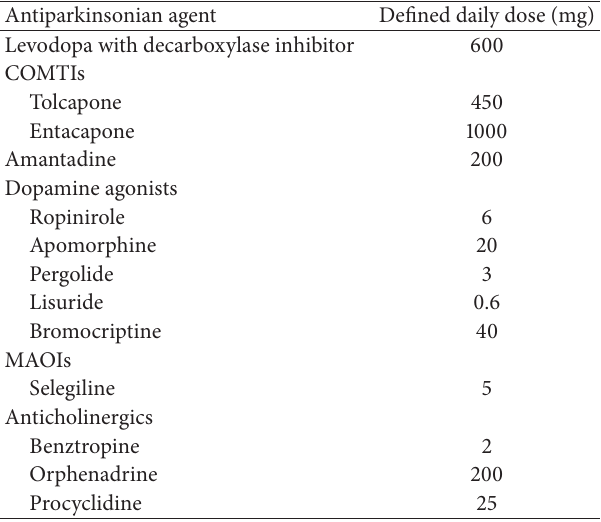
Table 1: Defined daily dose amounts for antiparkinsonian agents available in New